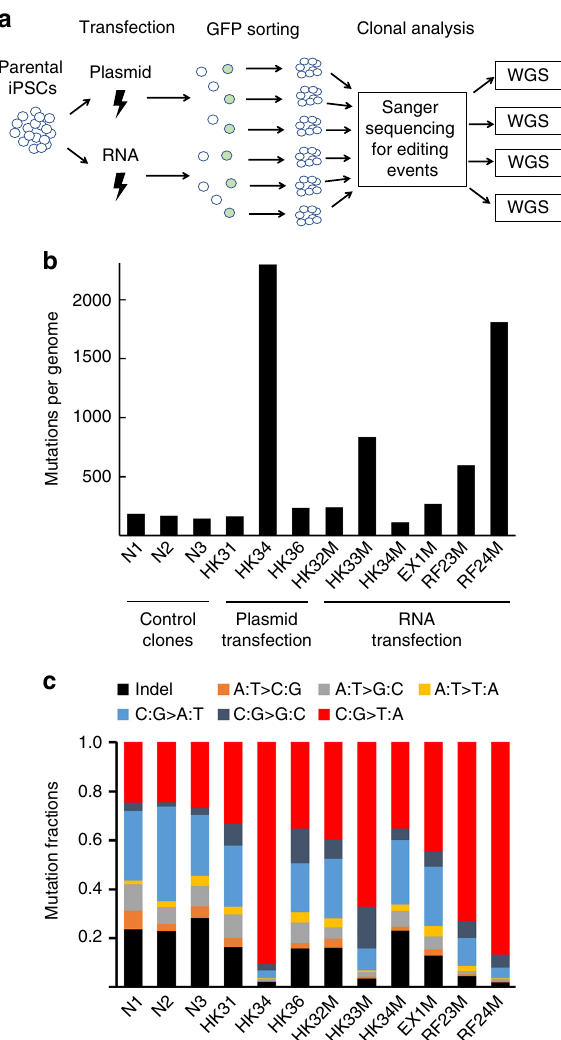
Fig. 2 Mutation frequencies in iPSC clones base-edited by transient transfection. a Diagrammatic representation of experimental design for whole-genome sequencing analysis of iPSCs edited at the HEK3, RNF2 or EMX1 locus after transient transfection with either the plasmid or the RNA form of base editor. Clones transfected by a GFP-only plasmid vector were used as procedure controls for the analysis. b Mutation numbers in control iPSC clones and base-edited iPSC clones after plasmid or RNA transfection. c Fractions of mutations in control and base-edited iPSC clones. Source data for b and c are provided in the Source Data fi